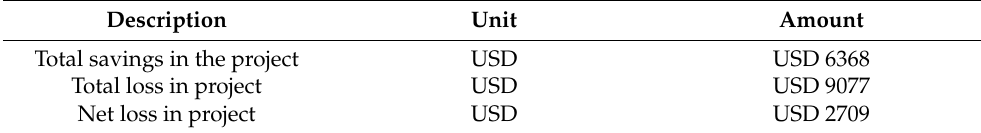
Table 12. Net loss in LSS project.